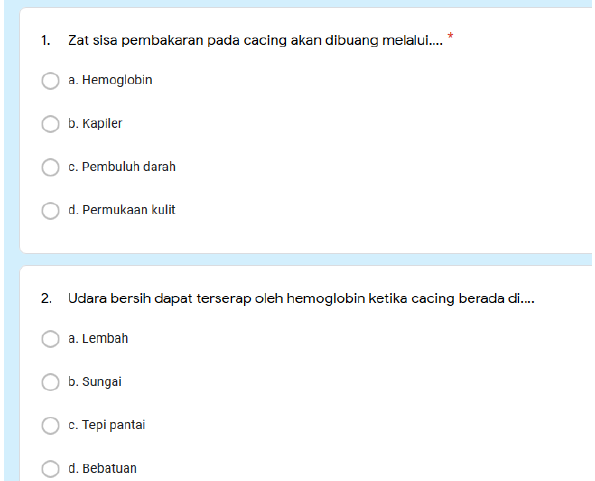
Figure 13. Judgement and critical thinking questions number 1 and 2, Package